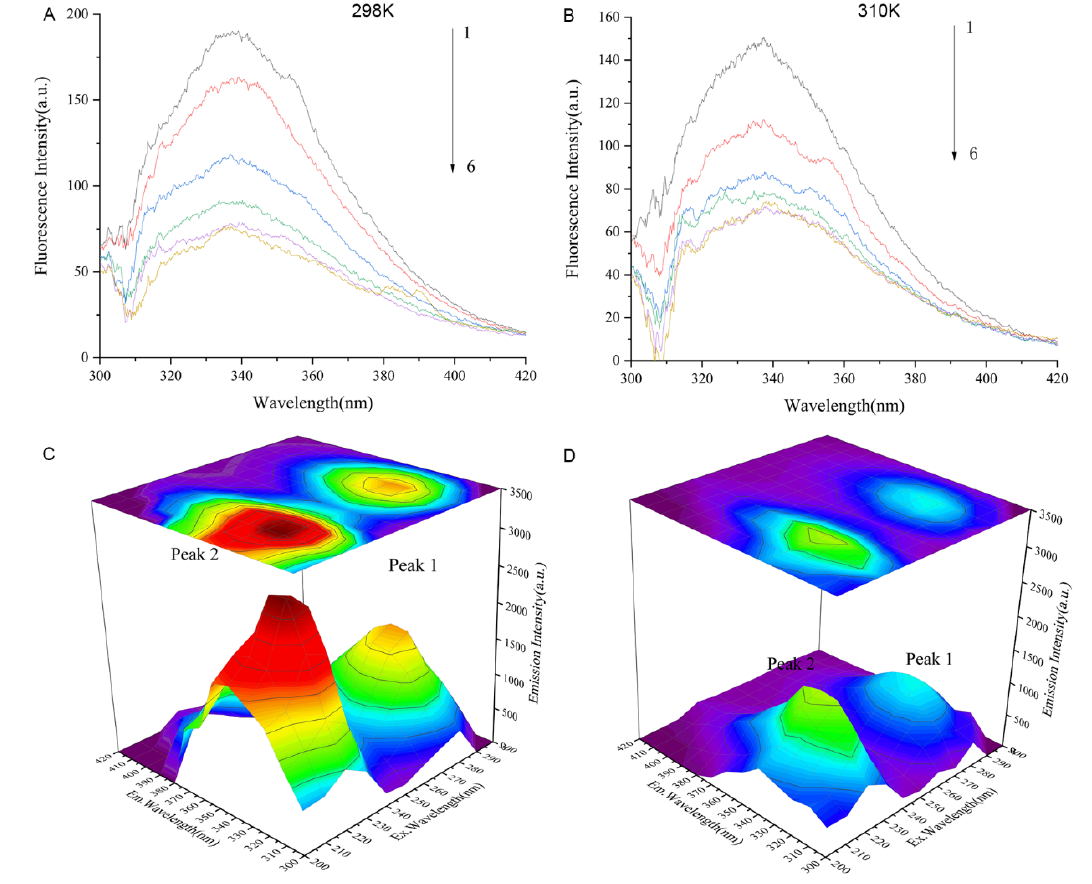
Figure 8. ( A ) Fluorescence quenching spectra of different concentrations of TDD on Cav1 protein at 298 K and ( B ) Fluorescence quenching spectra of different concentrations of TDD on Cav1 protein at 310 K. 1 → 6:0, 1.0 × 10 − 7 , 2.0 × 10 − 7 , 3.0 × 10 − 7 , 4.0 × 10 − 7 , and 5.0 × 10 − 7 mol/L. ( C ) Three-dimensional fluorescence spectra of CAV-1 and ( D ) Three-dimensional fluorescence spectra of TDD-CAV-1 system. TDD: 5 × 10 −7 mol/L.